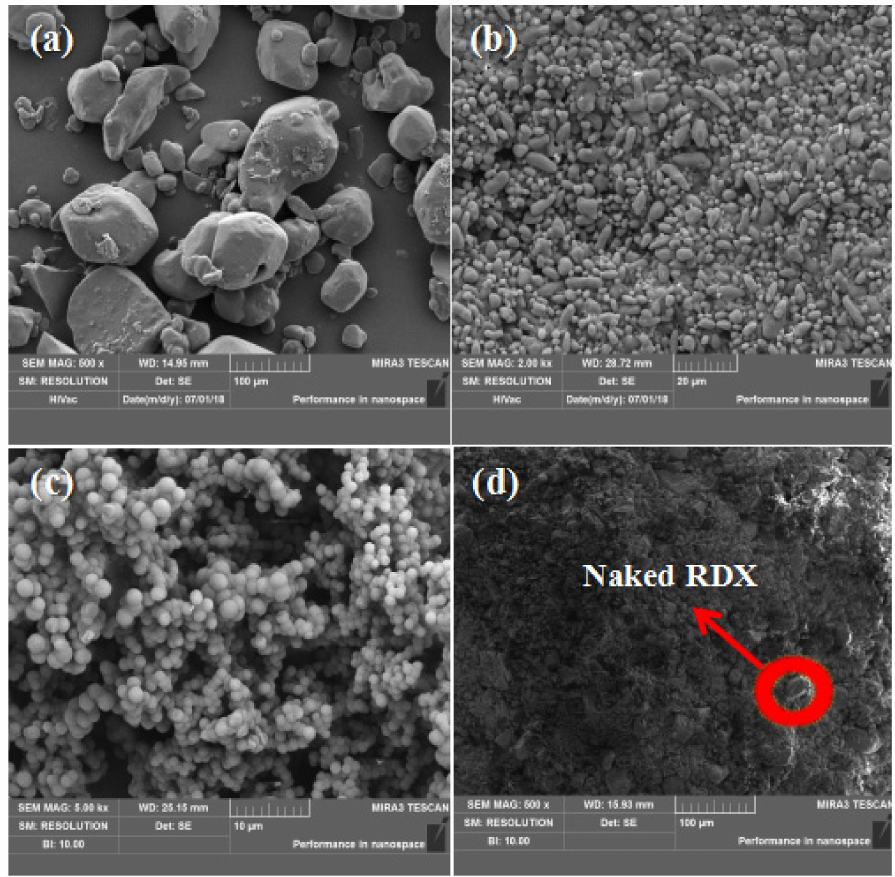
Figure 6. SEM of di ff erent RDX samples: ( a ) raw RDX, ( b ) refined RDX, ( c ) RDX / MUF-1, ( d ) RDX /